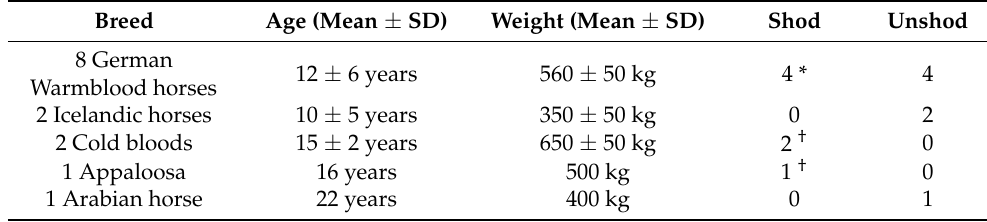
Table 1. Signalment of horses (age, weight, shod/unshod) with forelimb lameness included in the current study, divided by breed.